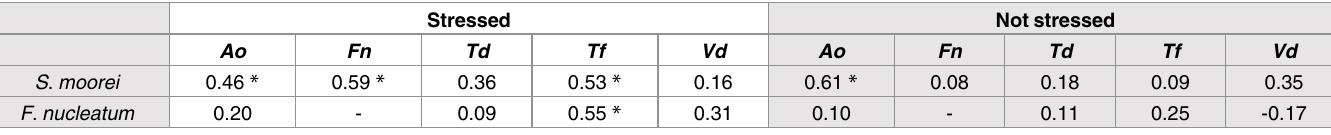
Table 3. Correlationcoefficients(rS) between the relativeproportions of S . moorei or F . nucleatum and the relativeproportions of A . odontolyticus ( Ao ), T . denticola ( Td ), T . forsythia ( Tf ), and V . dispar ( Vd ), for the “Stressed” and “Not stressed” groups. Stressed Not stressed